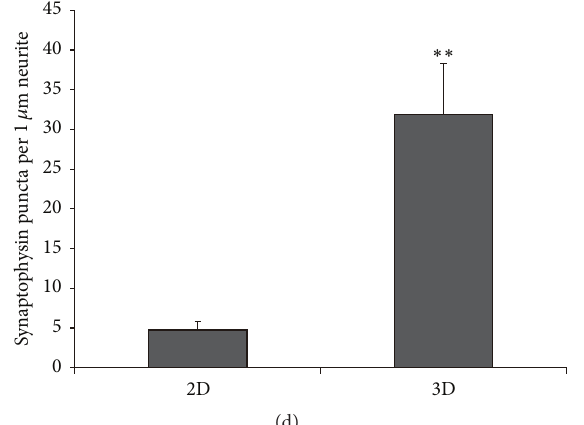
Figure 7: 3D culture elevated synapse density in SGN explants. (a) The diagram of the assay. (b) Representative images of SGNs explants immunostained with neurofilament (green) and synaptophysin (red) cultured in 2D and 3D systems. (c) Representative images in high magnification of synaptophysin (red) immunostained SGN explants in 2D and 3D systems. (d) Quantification of the number of synapse puncta in 2D and 3D systems. ∗∗ 𝑝 < 0.01